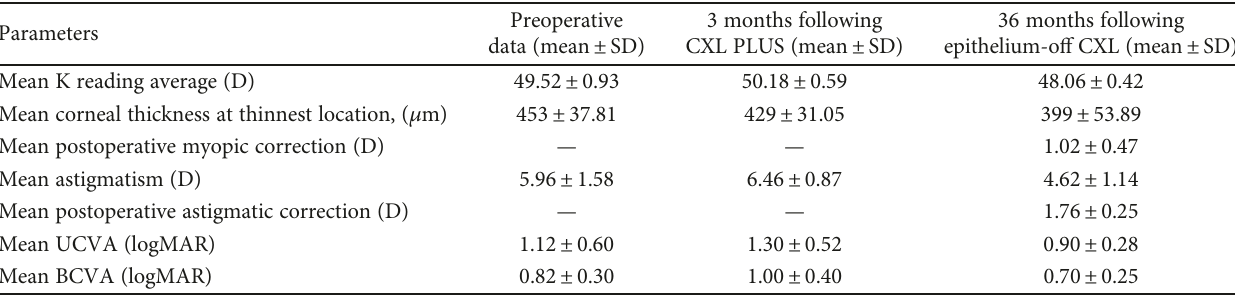
Table 4: The summary of the refractive data of the six complicated eyes (group